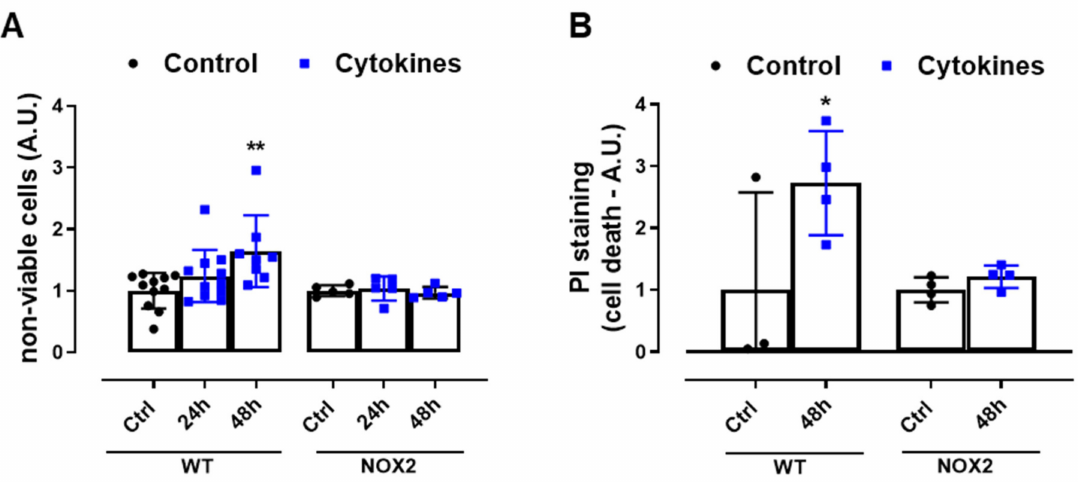
Figure 4. The viability of the islets from C57BL/6J (WT) and NOX2 KO (NOX2) mice exposed to proinflammatory cytokines. ( A , B ) The apoptosis of islets from WT and NOX2 KO mice after 24 or 48 h of incubation in 10-mM glucose in the absence (Control) or presence of a proinflammatory cytokine mix (10-U/mL IL-1 β + 100-U/mL TNF + 14-U/mL IFN- γ ). The apoptosis was assessed by flow cytometry using a ViaCount kit ( A ) or propidium iodide (PI) staining ( B ). For each individual experiment, the values were normalized by dividing the fluorescence of the islets exposed to cytokines by the average fluorescence of the respective untreated islets from the same genotype. The values are indicated as the fold change. The results are expressed as the mean ± SD of 5–11 ( A ) or 3 to 4 ( B ) independent experiments. * p < 0.05 and ** p < 0.01 versus the respective control of the same genotypes. One-way ANOVA +